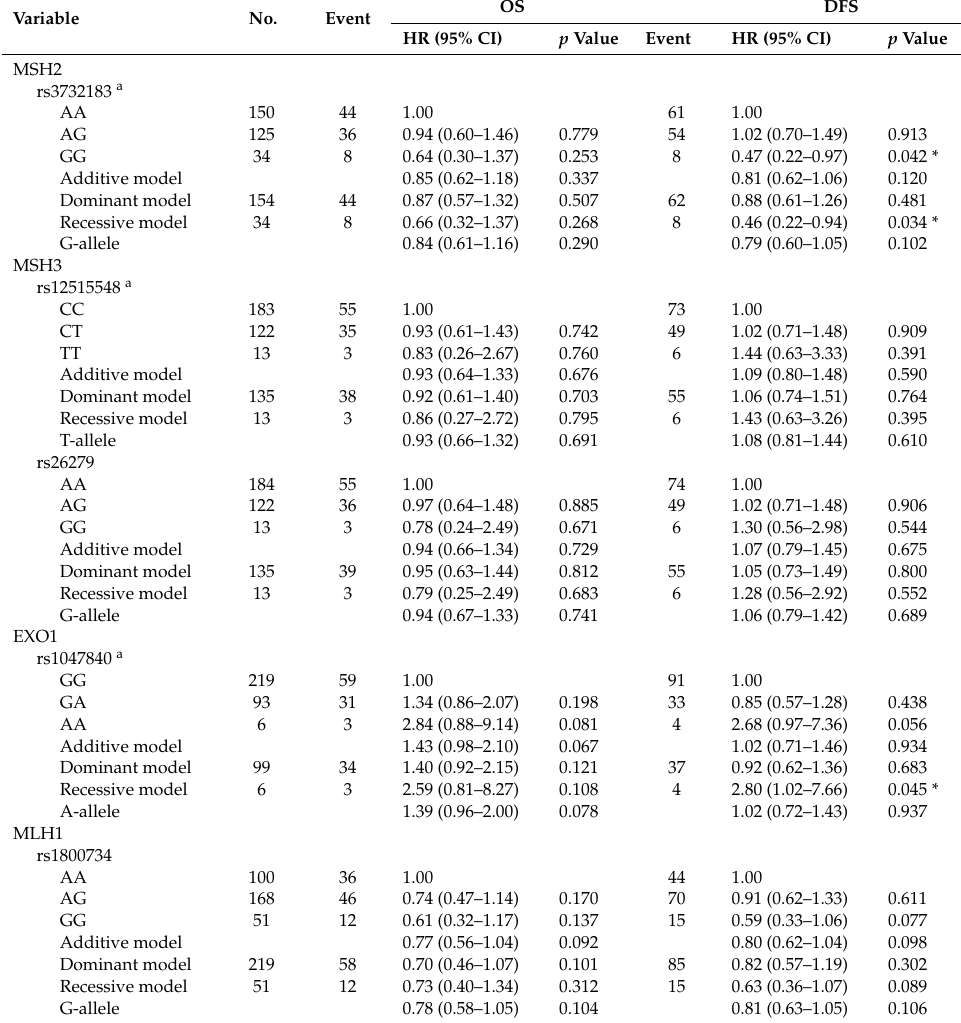
Table 3. Univariate association between candidate single-nucleotide polymorphisms (SNPs) in mismatch repair (MMR) genes and survival in patients with OSCC receiving concurrent chemoradiotherapy.